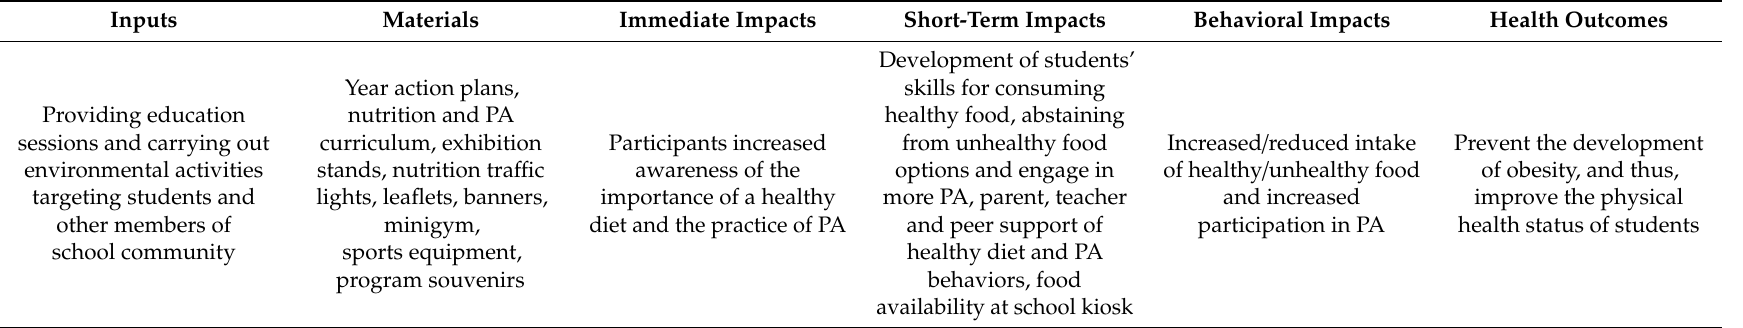
Table 1. Logic model for the Health Promoting Schools (HPS) Obesity Prevention Program.